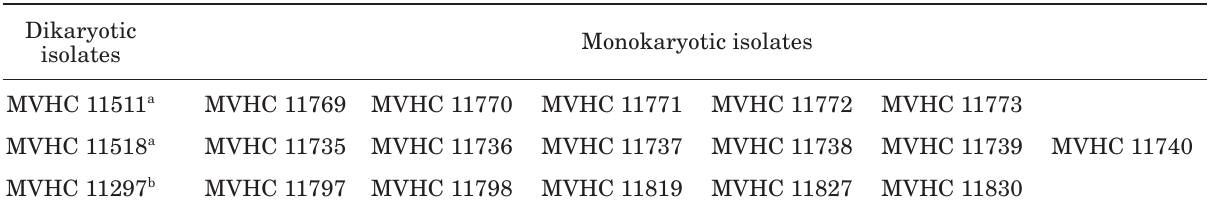
Table 1. Monokaryotic isolates obtained from dikaryotic isolates of Vitis vinifera a and Eucalyptus globulus b . Dikaryotic